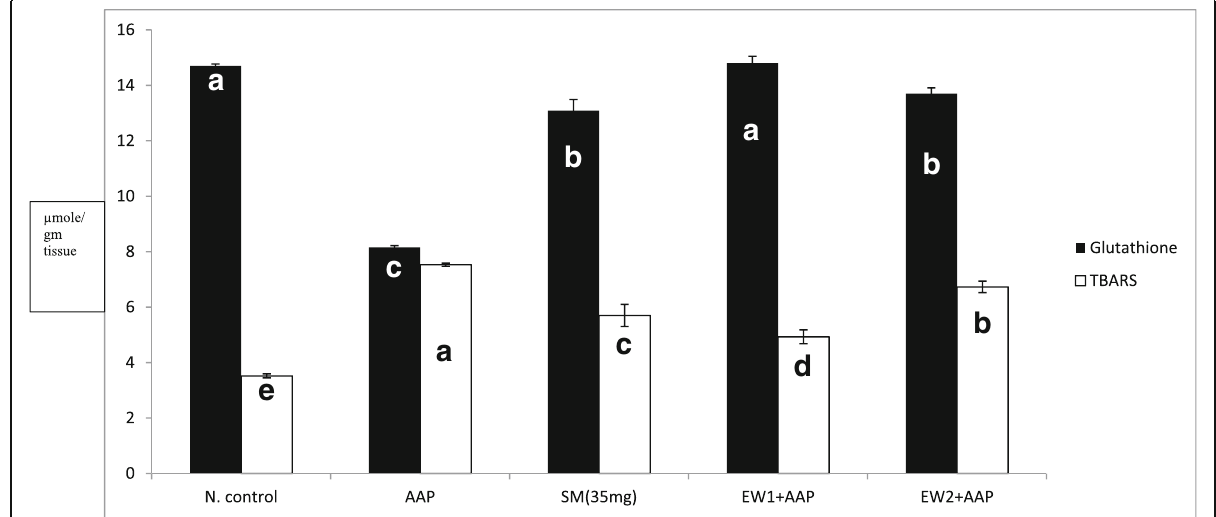
Fig. 1 Effect of Crude Sulphated Polysaccharides of Sargassum swartzii on Glutathione and Lipid Peroxidation (TBARS) in Acetaminophen Intoxicated Rats. The vertical lines in the bars showing means ± Standard error (n=6 animals per group).The values having the same superscript on the bars of same color are not significantly ( p < 0.05) different according to Duncan ’ s multiple range test. N. control= Normal control, AAP= Acetaminophen, SM Standard Drug Silymarin, EW1= Extracted with water at room temperature, EW2= Extracted with water at